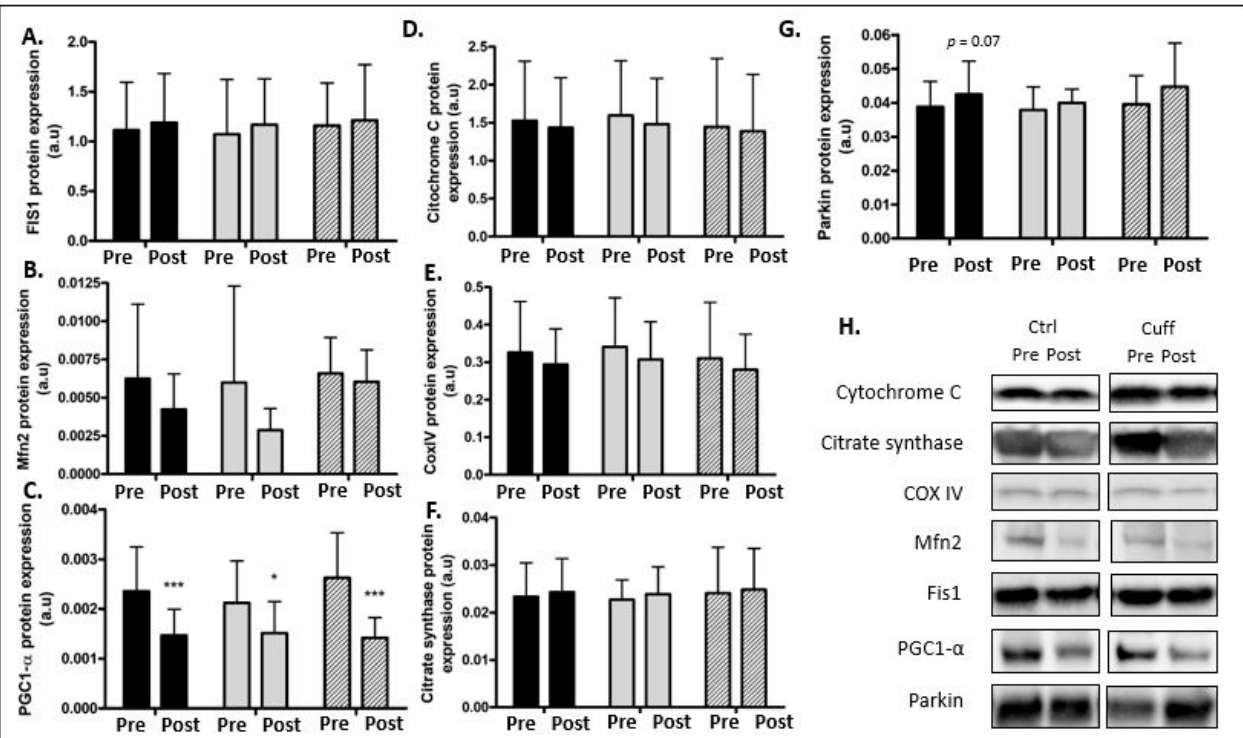
Figure 7. Effect of 5 days of DI on mitochondrial capacity. Mitochondrial content, activity, and biogenesis evaluated by western blot analysis. ( A ) FIS1 protein expression. ( B ) MFN2 protein expression. ( C ) PGC1- α protein expression. ( D ) Cytochrome C protein expression. ( E ) COXIV protein expression. ( F ) Citrate synthase protein expression. ( G ) Parkin protein expression. ( H ) Western blot picture analyzed by groups. * different from pre value in the same group. * p < 0.05; *** p < 0.001.